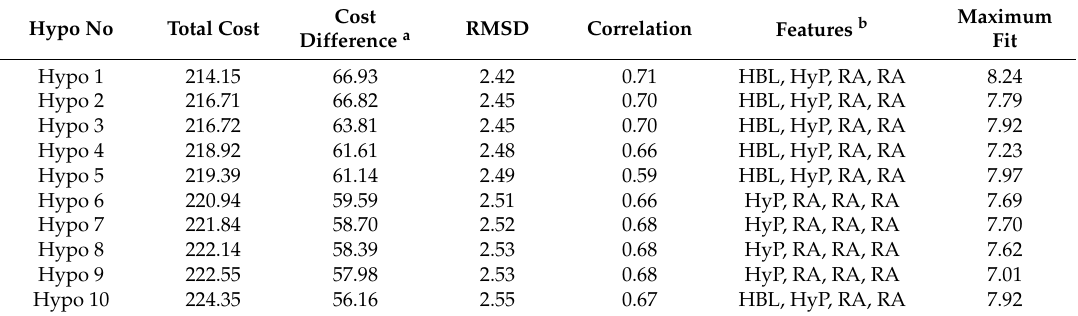
Table 1. Statistical and predictive significance presented in cost values for top 10 hypotheses generated due to 3D QSAR pharmacophore